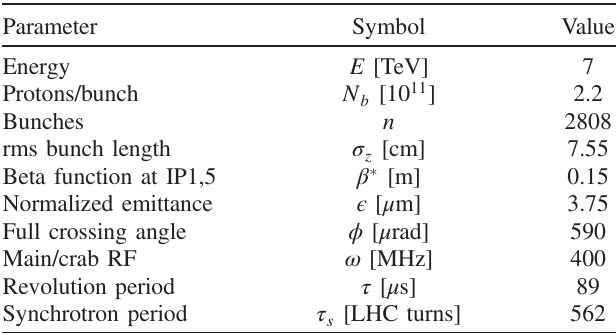
TABLE I. Relevant optics parameters of the